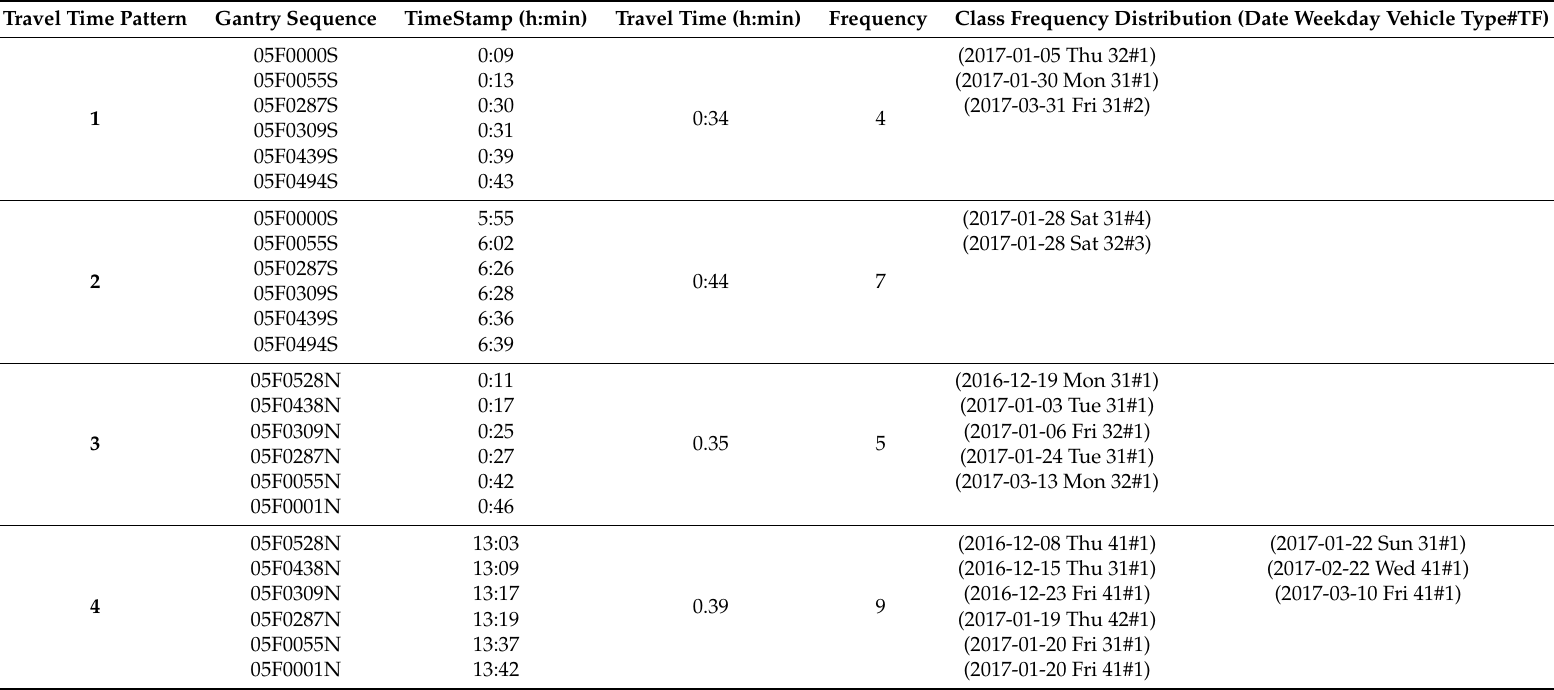
Table 4. Examples of significant travel time patterns extracted from the Freeway No. 5 gantry timestamp